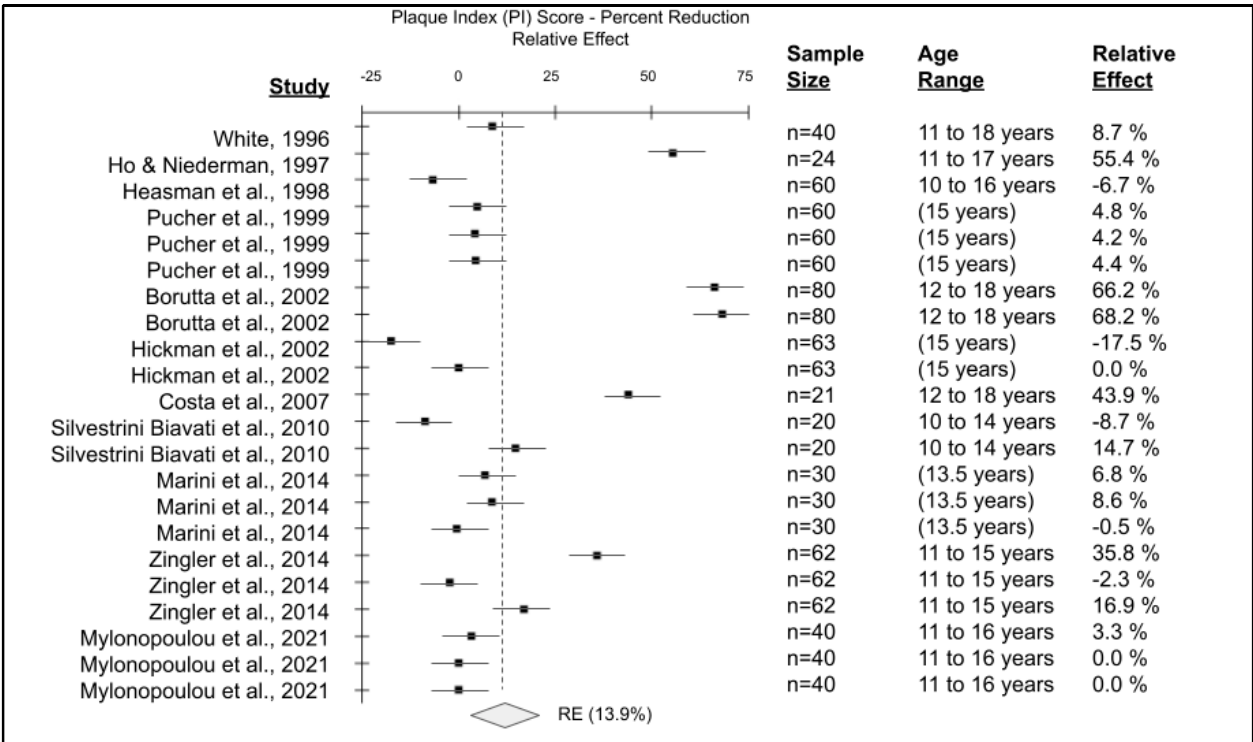
Table 3. Potential bias of all pediatric inclusion studies.